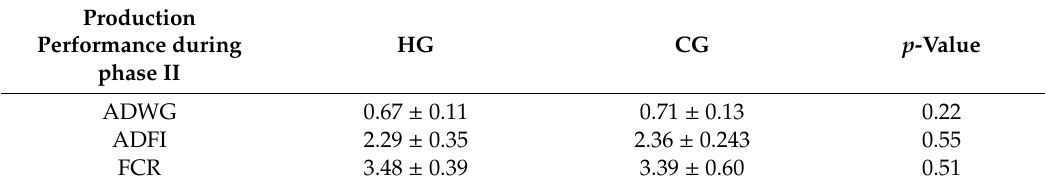
Table 5. E ff ect of gentle handling on production performance of pigs during phase II (mean ± standard deviation) ( p < 0.05).